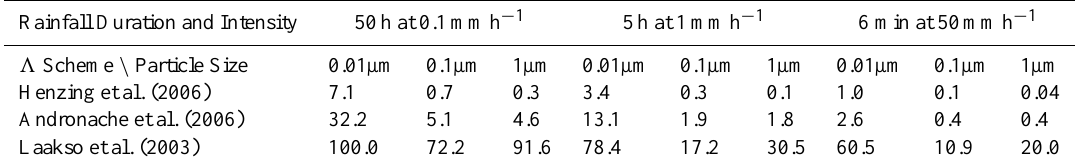
Rainfall Duration and